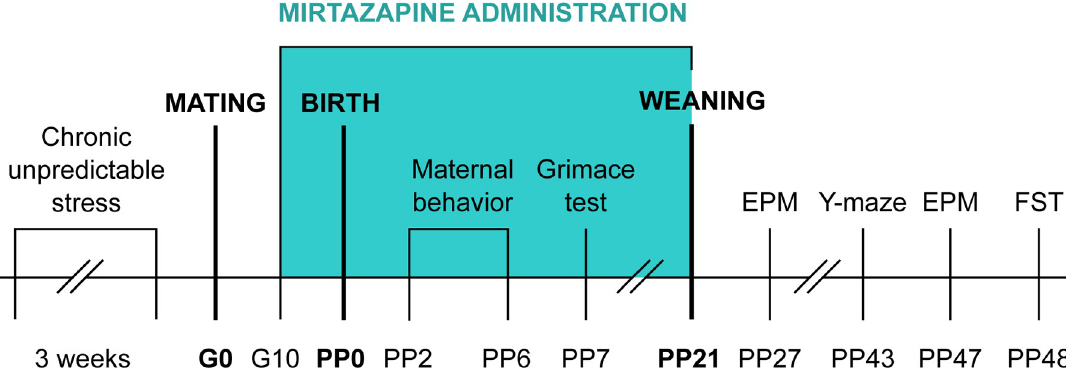
Fig 2. Schedule of the experiment. G- gestation day; PP-post-partum day; EPM- elevated plus maze; FST- forced swim test.